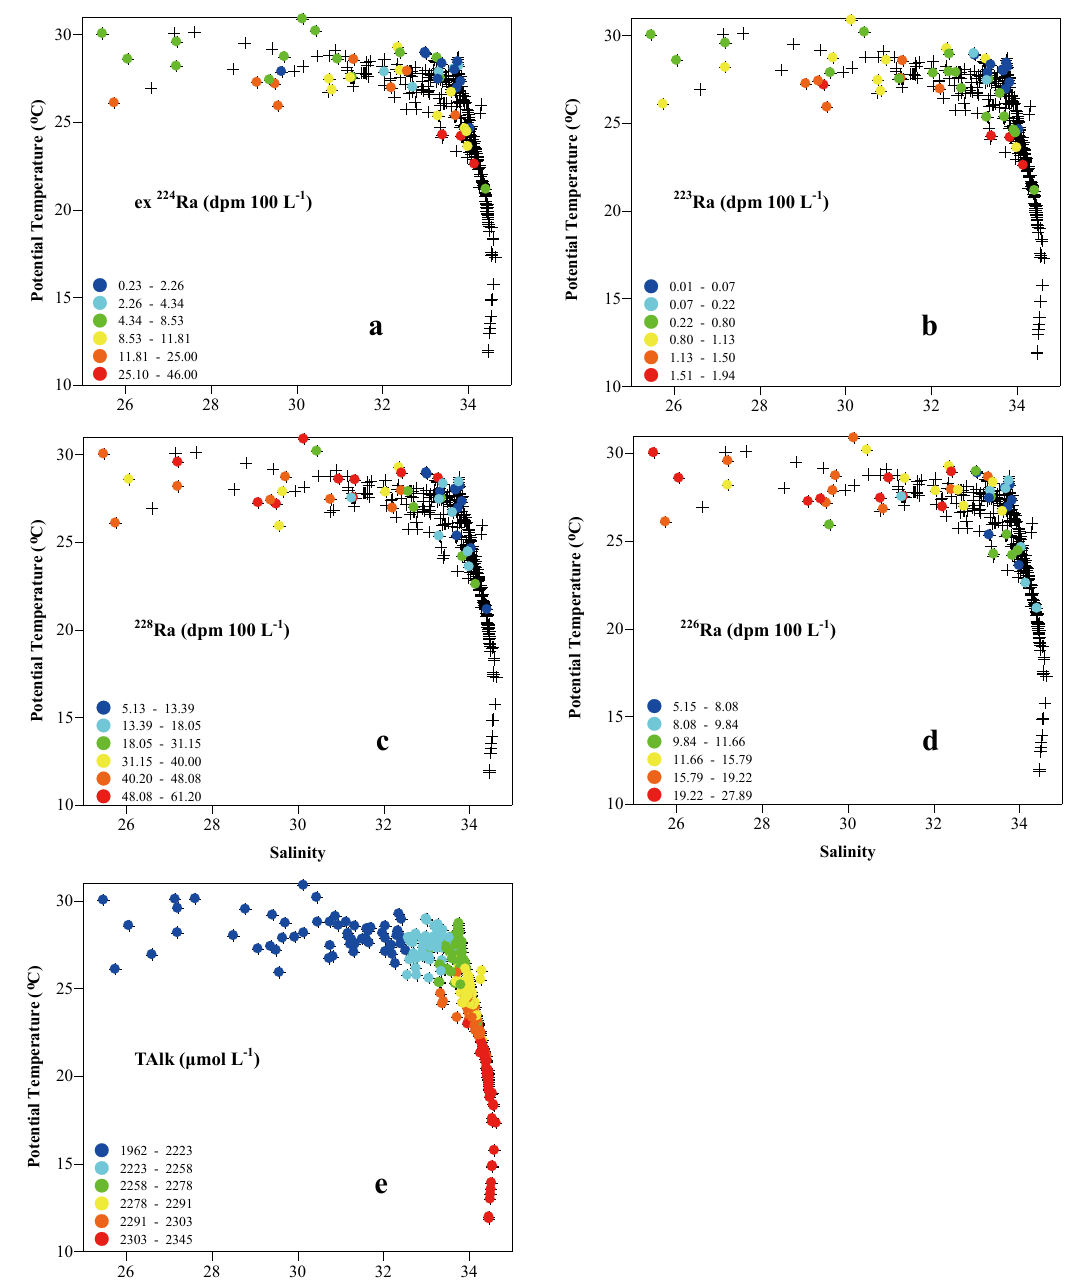
Fig. 5. Temperature-salinity diagrams superimposed with the data of (a) ex 224 Ra (excess 224 Ra, corrected for the ingrowth from 228 Th), (b) 223 Ra, (c) 228 Ra, (d) 226 Ra, (e) TAlk (total alkalinity). Crosses represent the temperature and salinity data. Circles are the Ra quartet and TAlk data for samples collected on the northern South China Sea shelf during 30 June–8 July,